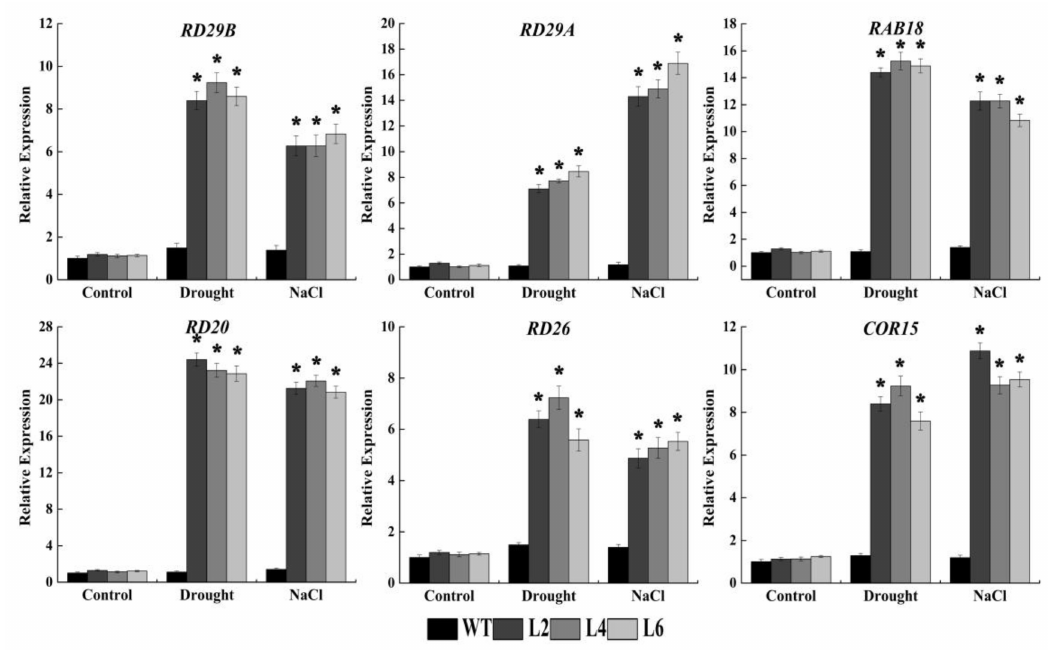
Figure 9. Analysis of ABA-dependent stress-related gene expression levels in transgenic lines and WT. Three-week-old Arabidopsis seedlings were treated without water and with 200 mM NaCl for one week until the RNA was extracted. The expression level of the WT under normal growth conditions was used as a control. The error bar represents the standard deviation between the three biological replicates. * Indicates that the expression level of the gene in the transgenic lines was significantly di ff erent from that in the WT. Significance was based on Student’s t-test ( p < 0.05).